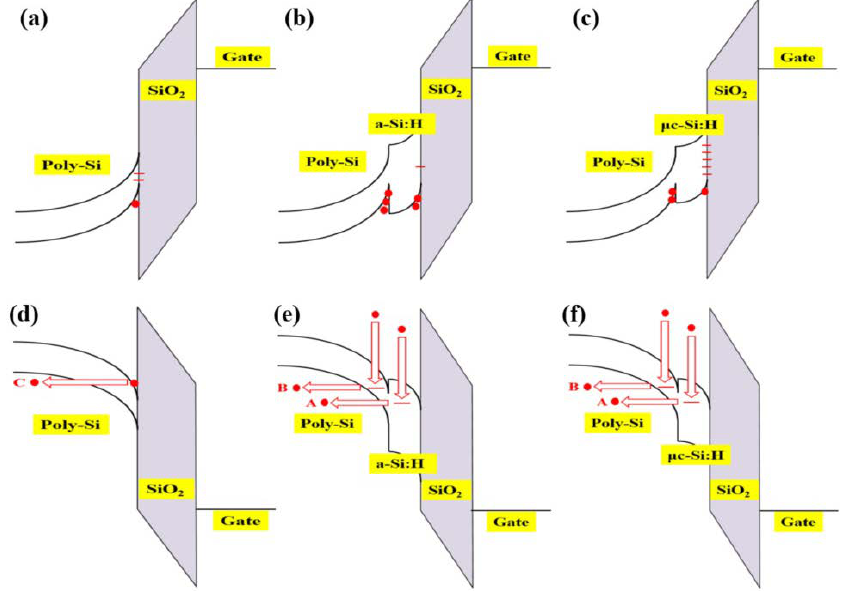
Figure 4. The schematic energy band diagram of p-channel LTPS TFTs with and without passivation layers under negative and positive gate bias based on the energy band difference, defect density, and current paths. ( a ) Only poly-Si under negative gate bias, ( b ) a-Si:H/poly-Si under negative gate bias, ( c ) µc-Si:H/poly-Si under negative gate bias, ( d ) only poly-Si under positive gate bias, ( e ) a-Si:H/poly-Si under positive gate bias, and ( f ) µc-Si:H/poly-Si under positive gate bias.